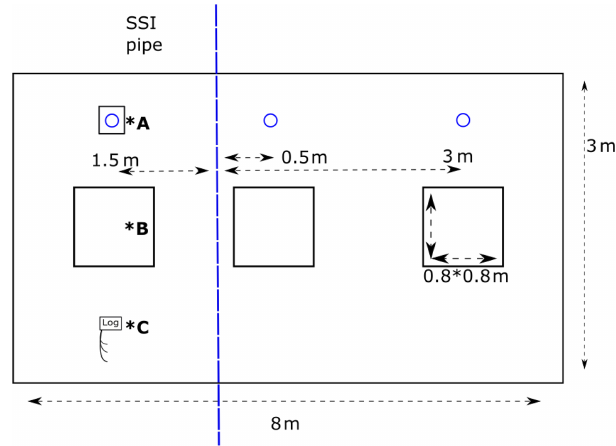
Figure 2. Overview field site SSI. Blue dashed line represents the SSI pipe, and the blue circle represents the dip well. ∗ A – dip well with data logger; ∗ B – greenhouse gas flux measurement frame; ∗ C – data logger; − 5, − 10 and − 20 soil